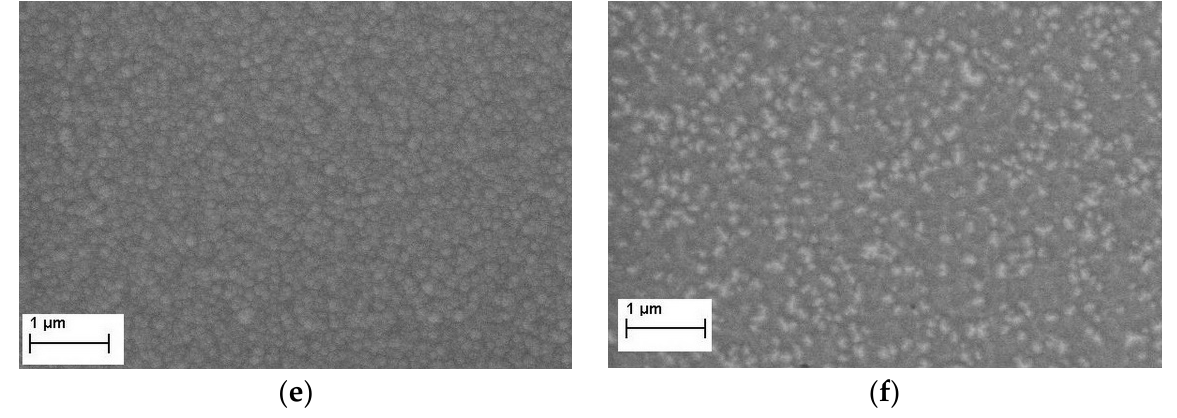
Figure 2. SEM images of coatings deposited with different bias values: ( a ) TaN1 −50 V, ( b ) TaAlN1 −50 V, ( c ) TaN2 −75 V, ( d ) TaAlN2 −75 V, ( e ) TaN3 −100 V, ( f ) TaAlN3 −100 V.